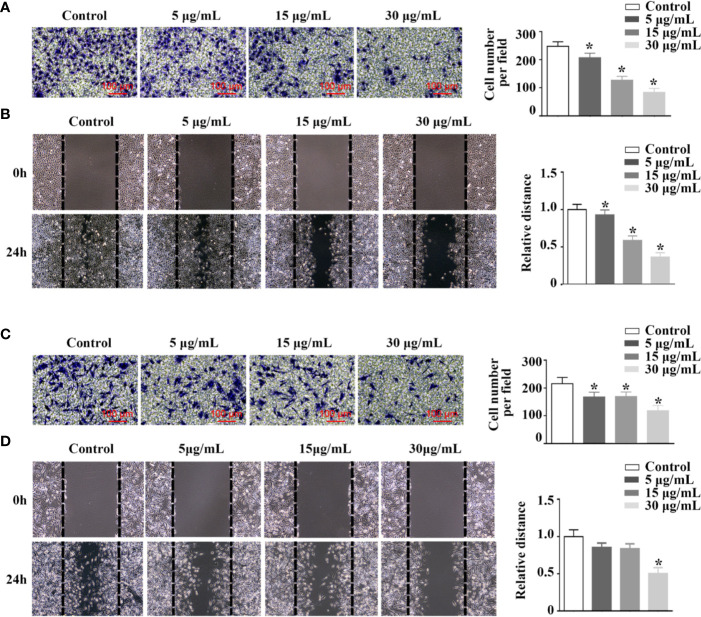
Effects of rFIP-mco on cell migration and invasion. Transwell migration assay (A) and cell migration monitored by the wound healing assay (B) were conducted in A549 cells treated with different concentrations of rFIP-mco. Transwell migration assay (C) and cell migration monitored by the wound healing assay (D) were carried out in HepG2 cells treated with different concentrations of rFIP-mco. *P < 0.05 vs. control groups (untreated cells).